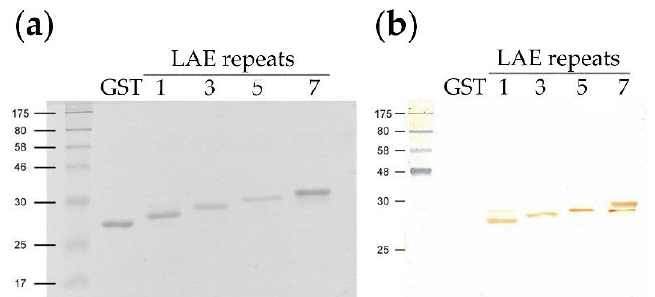
Figure 3. Western blot analysis of the gel-purified recombinant GST fusion protein (GST) and GST-PADRE-(RNNQIPQDF)n-Toxin B fusion proteins (LAE repeats: 1, 3, 5 and 7). ( a ) SDS-PAGE (16%) of the fusion proteins stained with Coomassie blue. ( b ) Western blot using the pre-pooled pig anti-PTV-1–7 serum as the primary